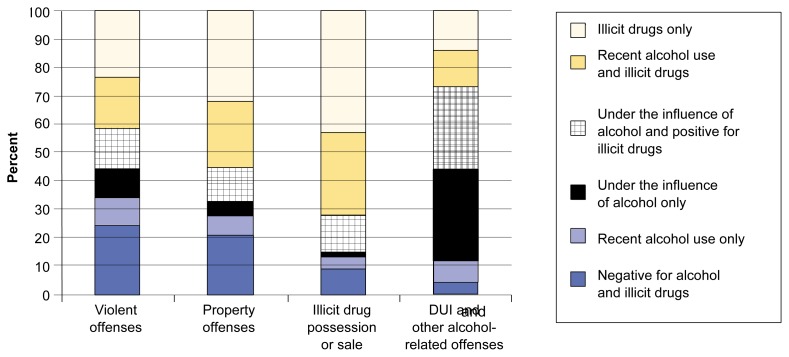
Alcohol- and drug-use combinations by type of charge at arrest.DUI = driving under the influence.SOURCE: U.S. Department of Justice 1999.